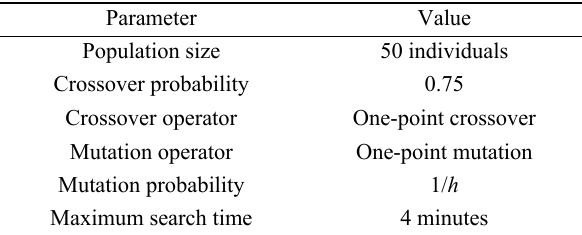
Table 2 Parameter